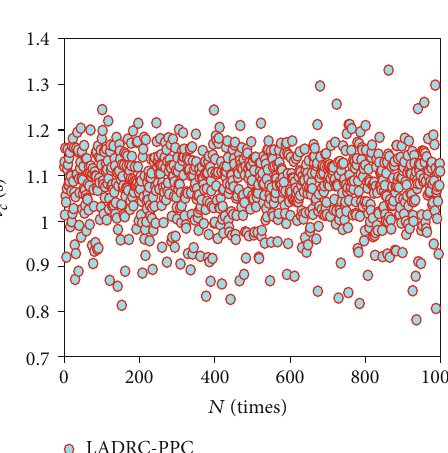
Figure 16: Estimation of f with LADRC-PPC.